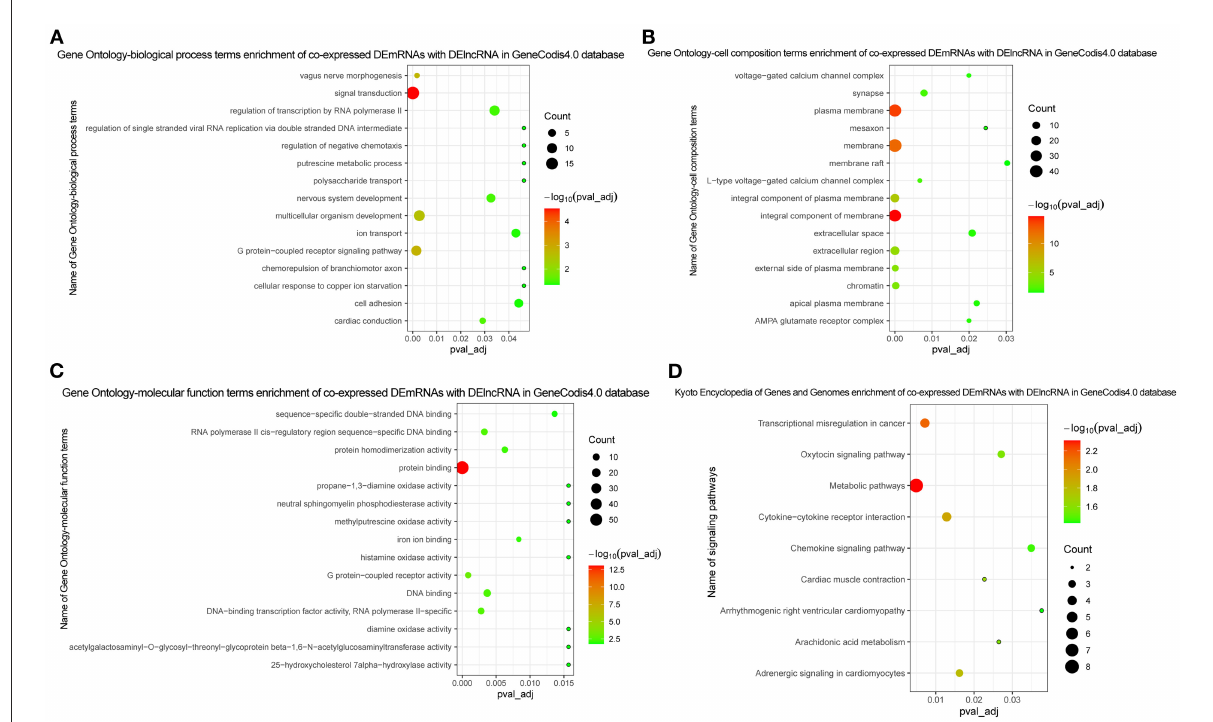
FIGURE5 Functional enrichment of co-expressed DEmRNAs with DElncRNA. (A) In GO function enrichment analysis, top 15 significantly enriched biological process of co-expressed DEmRNAs; (B) In GO function enrichment analysis, top 15 significantly enriched cell composition of co-expressed DEmRNAs; (C) In GO function enrichment analysis, top 15 significantly enriched molecular function of co-expressed DEmRNAs; (D) In KEGG function enrichment analysis, all enriched signaling pathways of co-expressed DEmRNAs. The bubble on the graph represents the size of the pval_adj, the more red the more significant. The screening criteria was pval_adj <